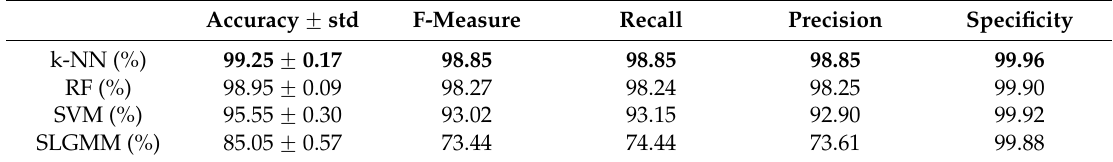
Table 7. Performances of the supervised algorithms using extracted features.